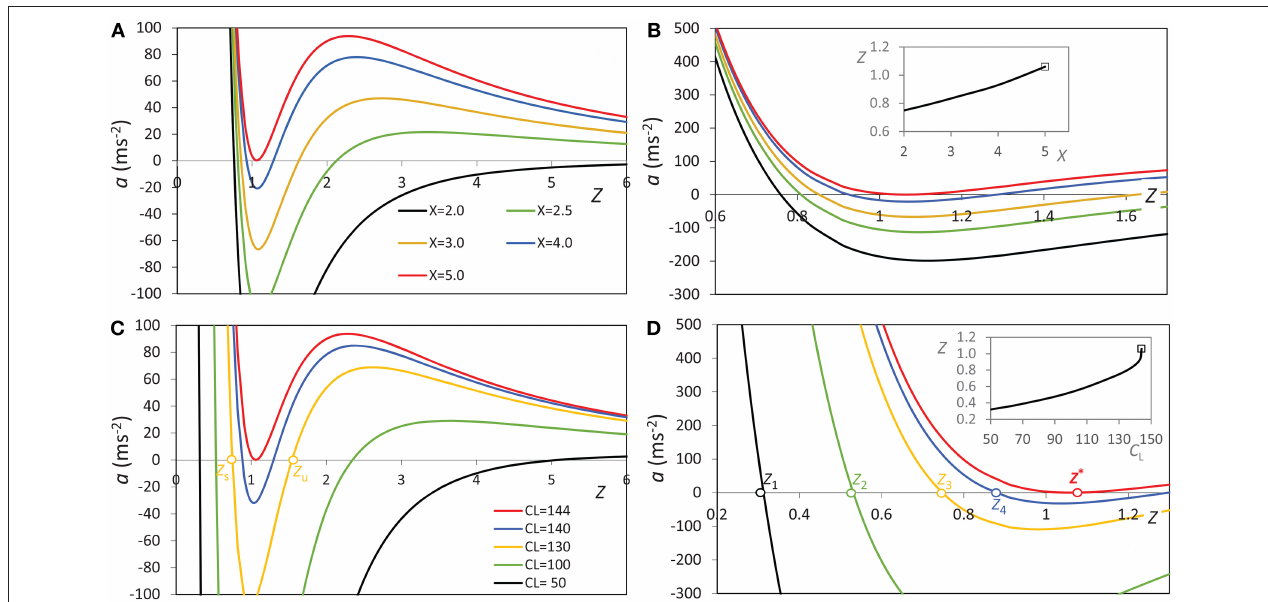
FIGURE 5 | Equation of motion results shown in the form a ( Z ) dependencies: (A) a ( Z ) curves for different values of X , combined with C L = 144ms − 2 ; (B) a part of (A) enlarged, focusing on the equilibrium heights; (C) a ( Z ) curves for different values of C L , combined with X = 5; (D) a part of (C) enlarged, focusing on the equilibrium heights. In (C) a pair of stable- and unstable-equilibrium heights on the yellow a ( Z ) curve is denoted by Z s and Z u , respectively. In all graphs a fixed value C c = 1.3 × 10 4 ms − 2 is used [see Equation (3)]. In (D) the stable-equilibrium heights Z s are marked as Z 1 , Z 2 , Z 3 , and Z 4 , whereas the height at which the flux rope losses equilibrium is denoted as Z ∗ (the red a ( Z ) curve). Insets in (B,D) show the increase of stable-equilibrium height as a function of X and C L ,